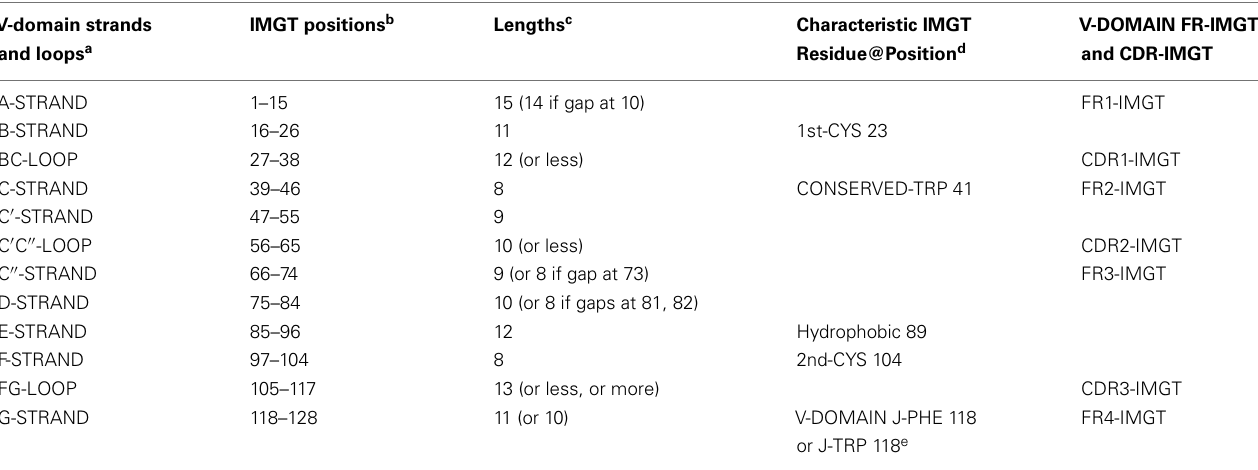
Table 4 |V-domain strands and loops, IMGT positions, and lengths, based on the IMGT unique numbering forV-domain (V-DOMAIN and V-LIKE-DOMAIN)